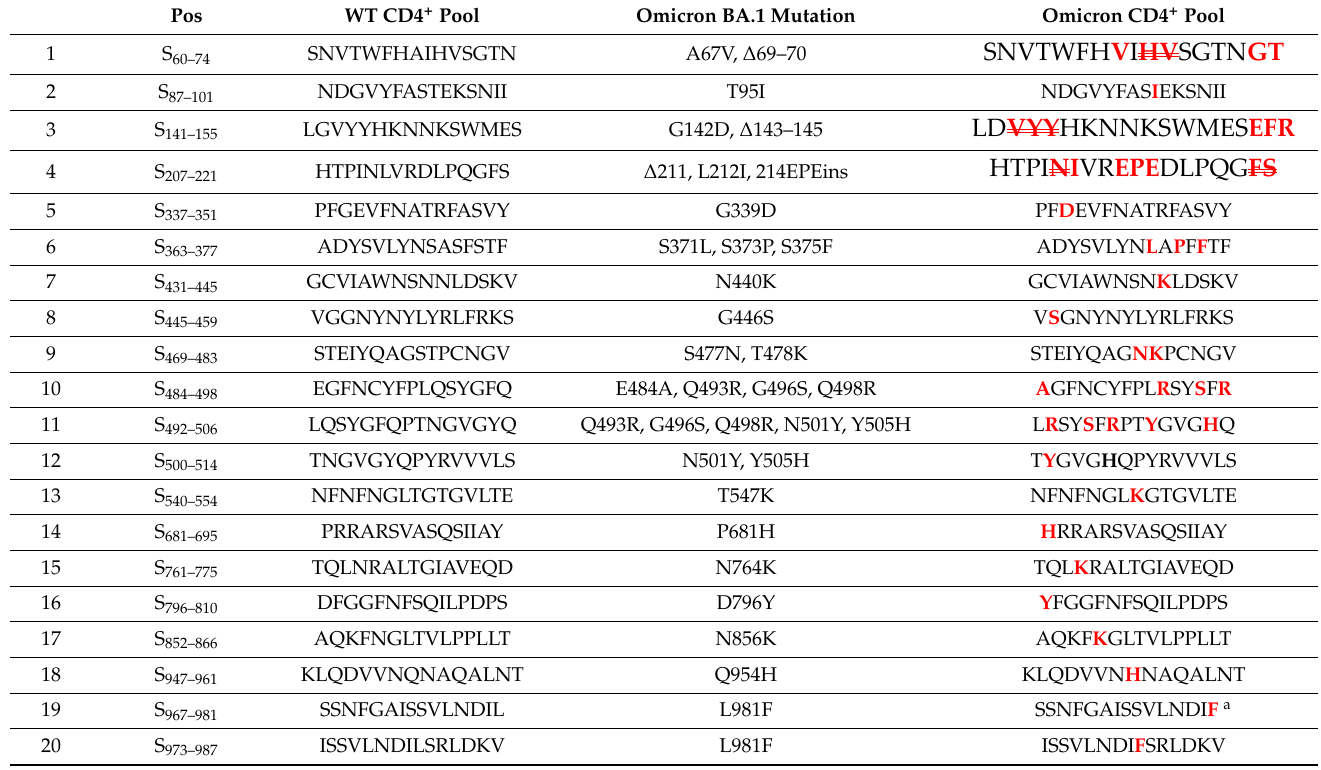
Table 1. List of selected CD4 + T-cell epitope candidates of spike protein of the wild-type reference strain having mutations in the corresponding Omicron BA.1 variant sequence.